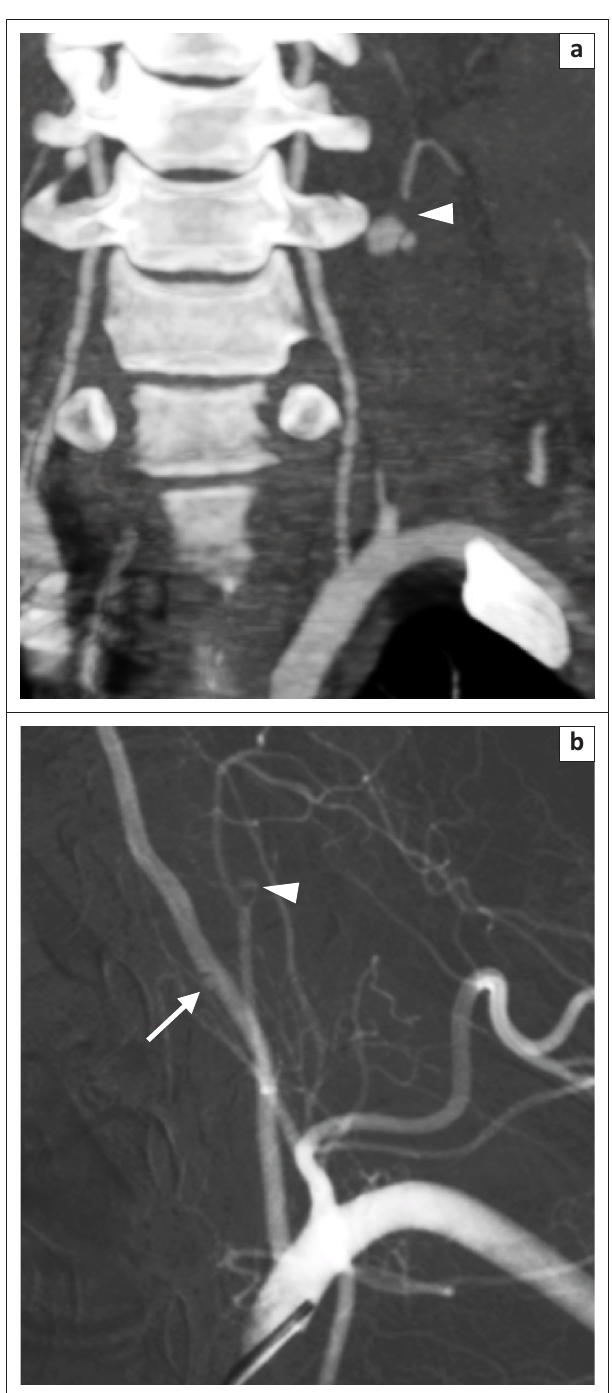
FIGURE 3: (a) The coronal reformatted MIP CTA image demonstrates no extraforaminal (part one) vertebral artery injury. On the selected DSA of the left subclavian artery (b), the arrow shows a subtle vertebral artery pseudo-aneurysm. The arrowheads on both images depict a pseudo-aneurysm arising from the ascending cervical